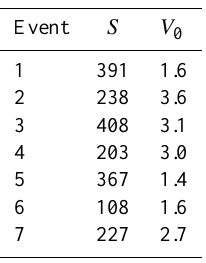
Table 3. S and V 0 parameters calibrated at the Anduze station, for the seven events